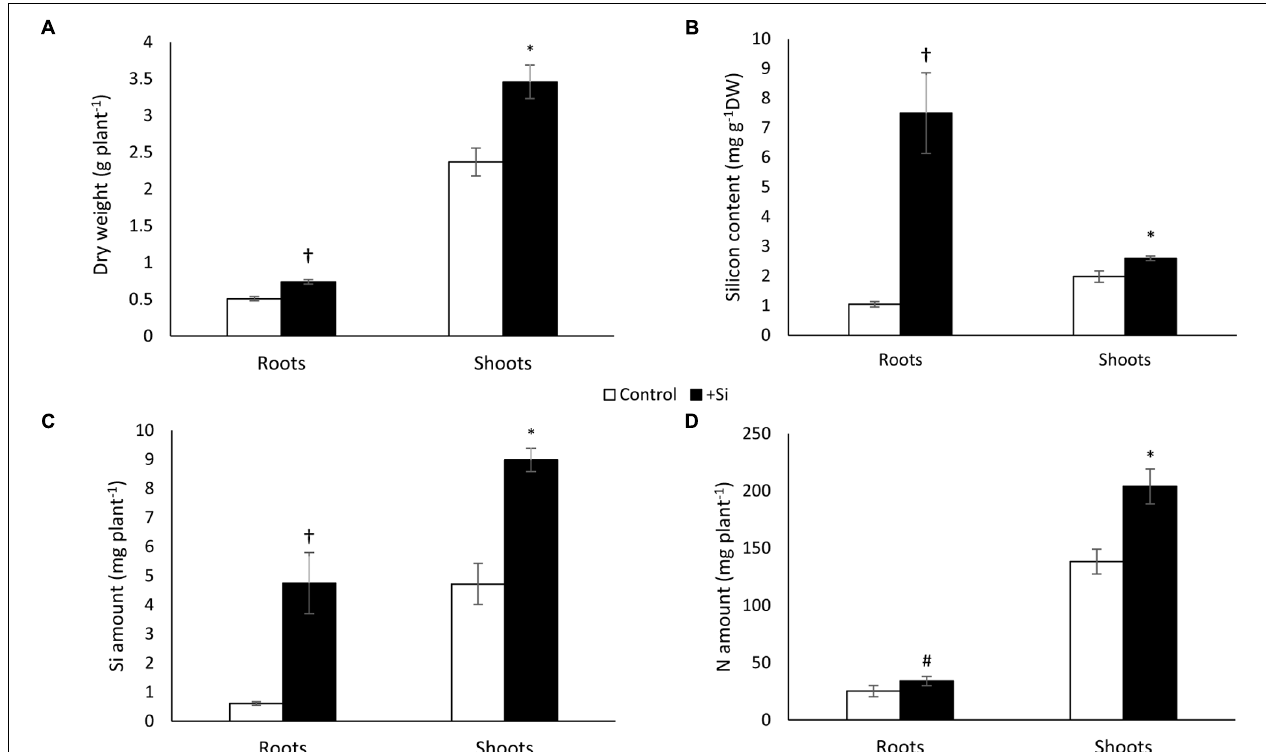
FIGURE 2 | Dry weight (A) , total silicon amount (B) , silicon content (C) and total nitrogen amounts (D) in shoots and roots of Brassica napus L. at the end of the Si pretreatment (Day 0). This harvest time (Day 0) corresponds to the end of the pretreatment period of plants with (+Si) or without Si (–Si; Control). Data are means ± SE (for n = 4). ∗ and † indicate significant differences between –Si (control) and +Si plants with p < 0.05 and p < 0.001,